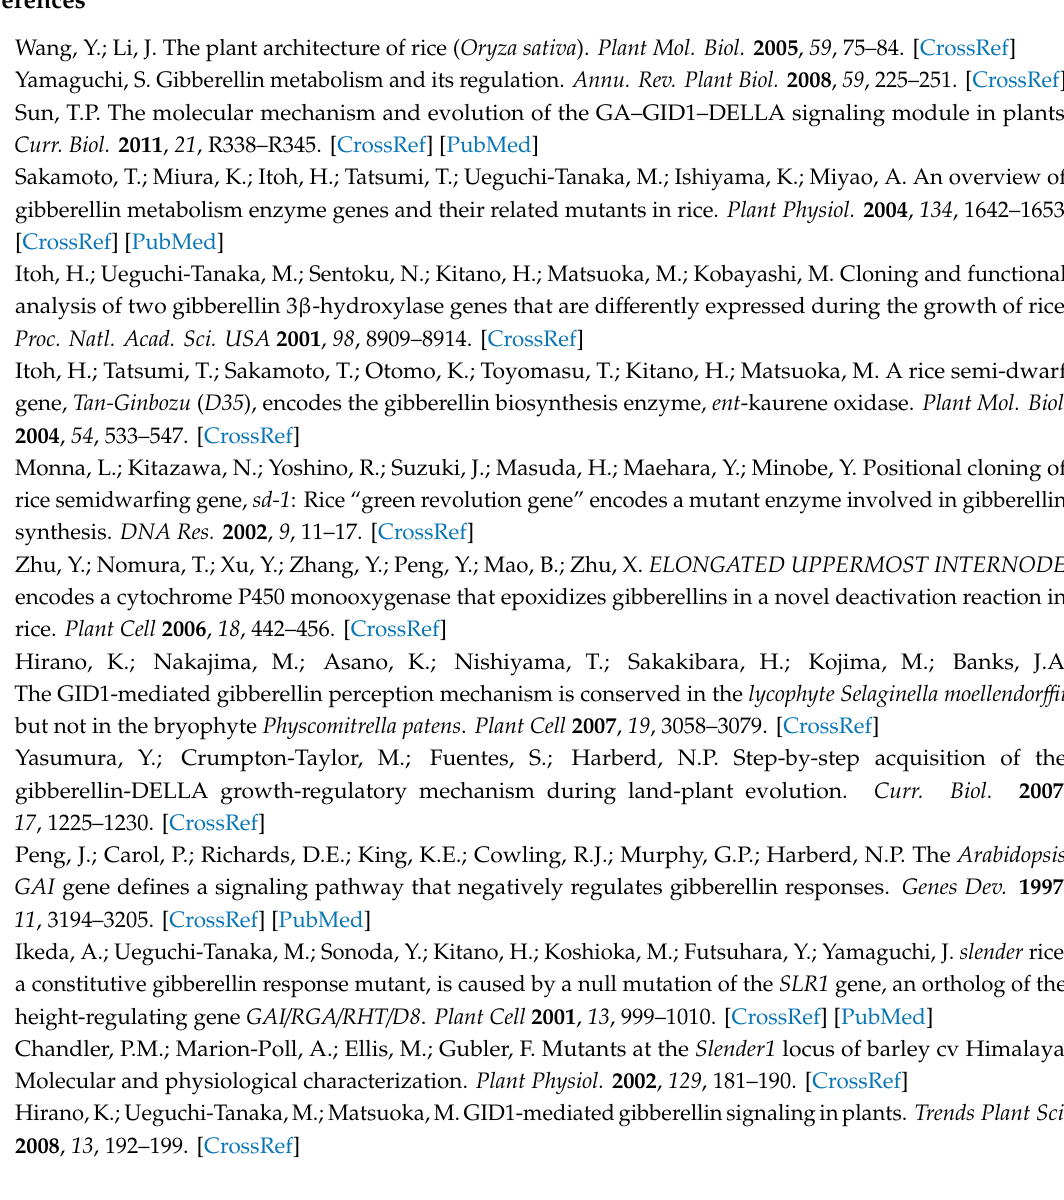
enzyme. Figure S4. CRISPR / Cas9 binary vector construction and rice transformation. Figure S5. Confirmation of the mutant phenotype and the conserved domain region of the DELLA protein. Figure S6. CRISPR / Cas9-induced mutations in the OsSLR1 gene and the phenotype of the edited plants. Figure S7. Appearance of the panicle, leaves and grains after harvesting slr1-d7 and slr1-d8 lines compared to WT. Table S1. Design of sgRNAs for CRISPR genome editing on the OsSRL1 gene in rice. Table S2. Mutation rate and edited plant types for the OsSLR1 gene using the CRISPR / Cas9 system. Table S3. GO enrichment analysis of DEGs by RNA-seq analysis. Table S4. Key DEGs of up- and down-regulated genes related to phytohormone biosynthesis and signaling transduction pathway by RNA seqs in WT vs slr1-d7 and WT vs slr1-d8 lines. Table S5. List of primers and gene sequences in DEGs, correlation analysis of gene expression pattern by RNA-Seq and